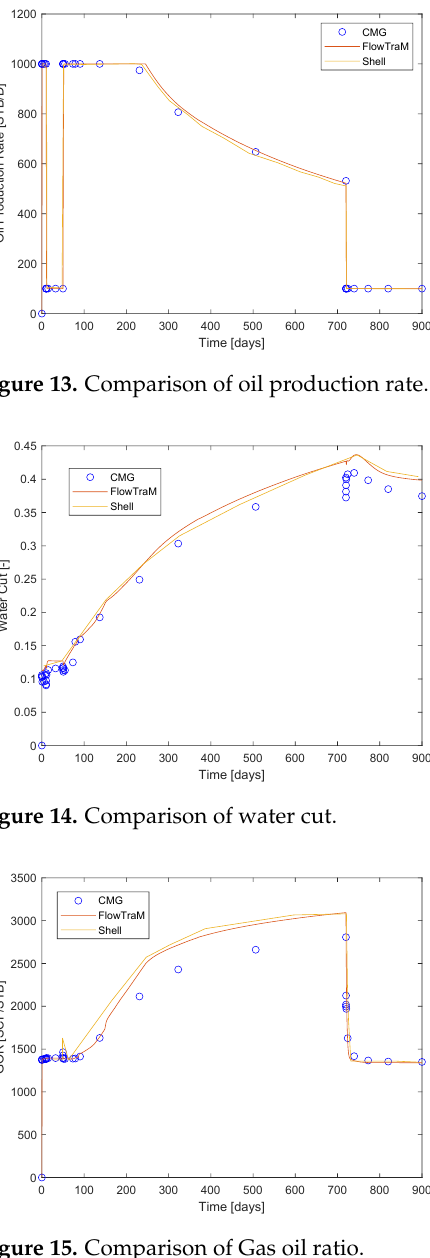
Figure 15. Comparison of Gas oil